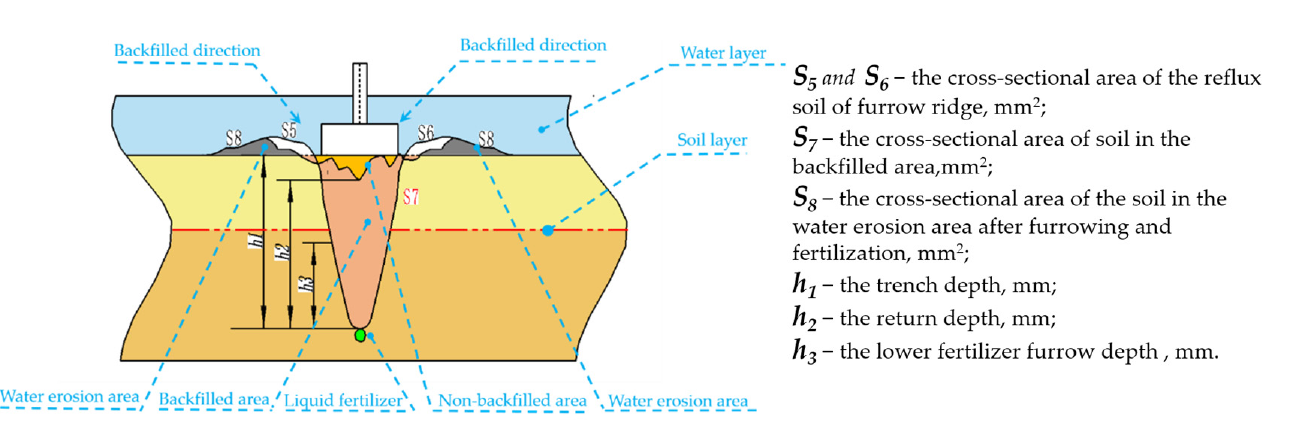
Figure 11. Schematic diagram of the soil reflux.